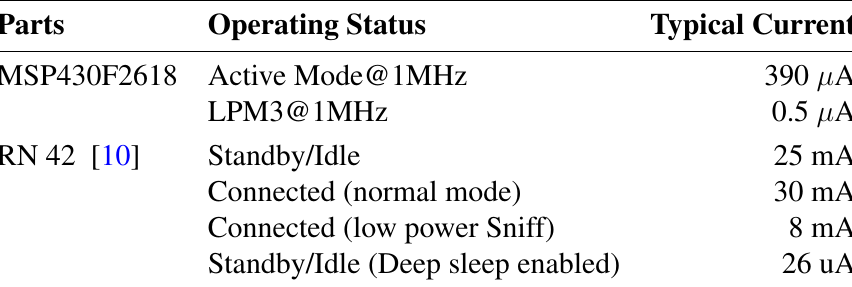
Table 2. Power consumption of the parts in